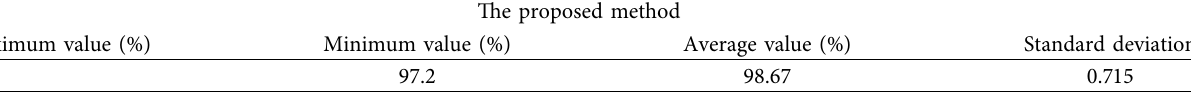
Table 2: Gear box fault detection results using the proposed method.